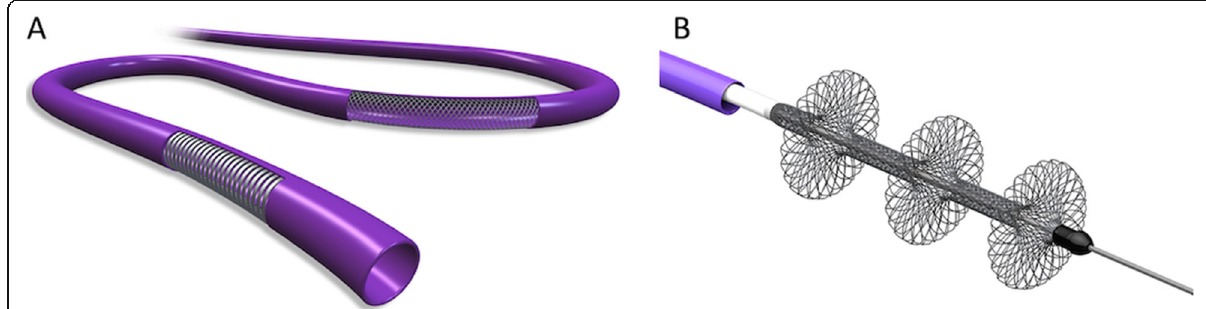
Fig. 1 The FlowTriever System. a The FlowTriever System consists of a 20Fr/95 cm catheter, called the Triever20, which is placed through the right heart into the pulmonary artery. The Triever20 can be used by itself to perform suction thrombectomy or can be used as a guide through